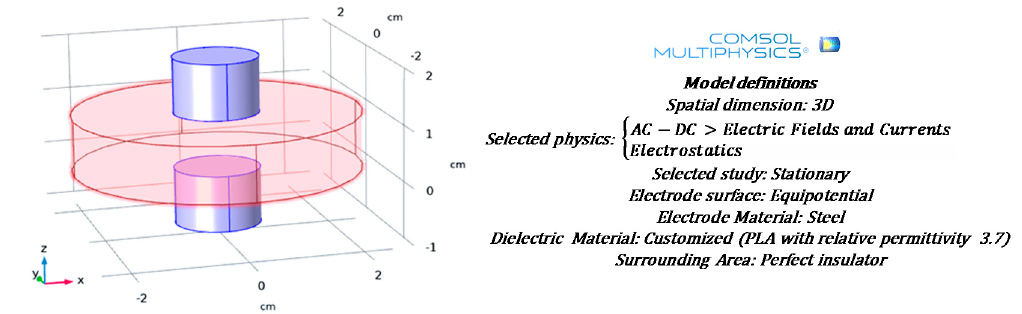
Figure 5. Schematic representation of a simulated capacitor composed of a specimen (that acts as dielectric) and steel plates on either side mimicking the measuring electrodes. The main model definitions are also reported.